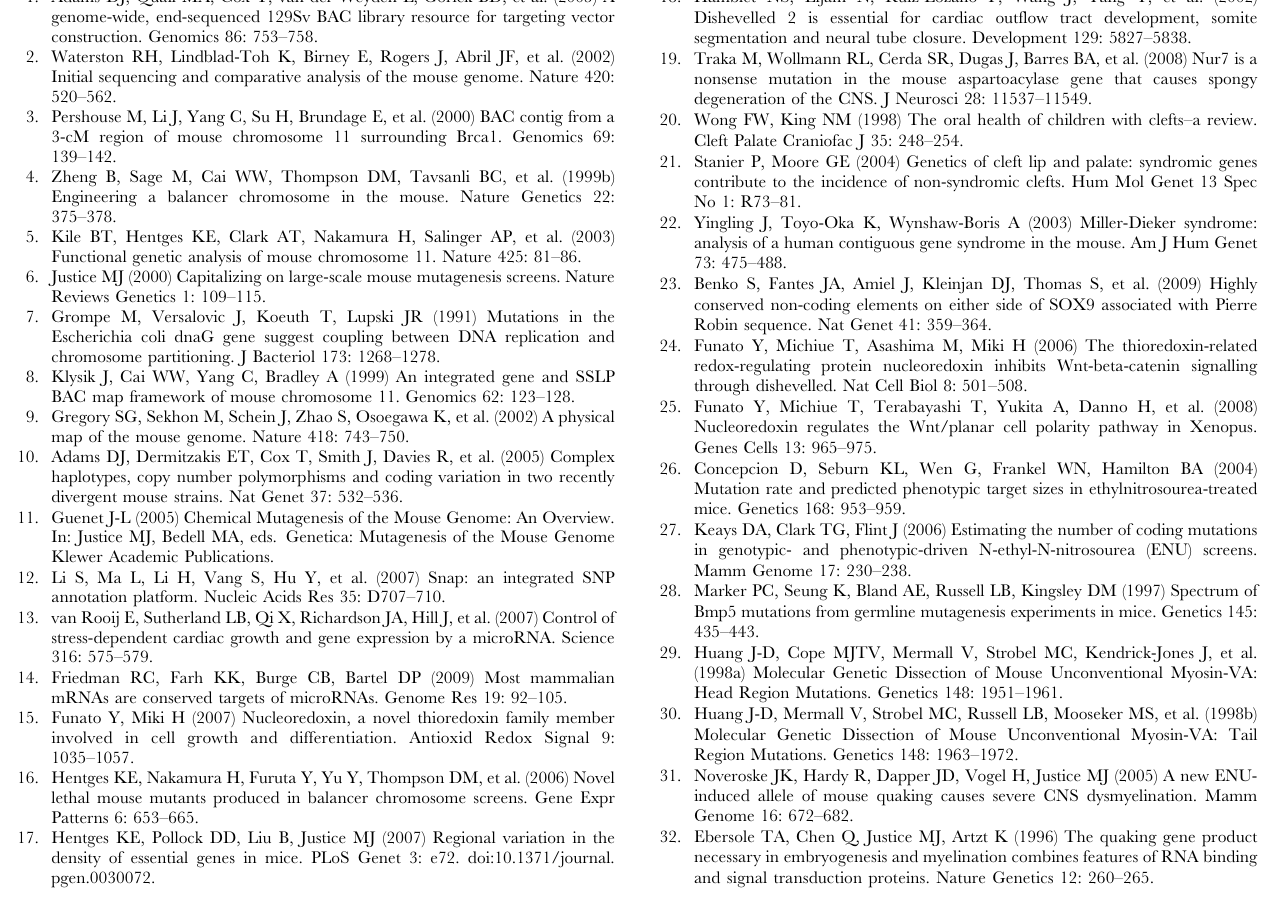
Table S7 Primers used to confirm Chromosome 11 ENU- induced mutations. Table S8 Microsatellite markers and SNPs used in mapping l11Jus13 ( Nxn J13 ). PCR conditions are available upon request. F denotes forward primer, R denotes reverse